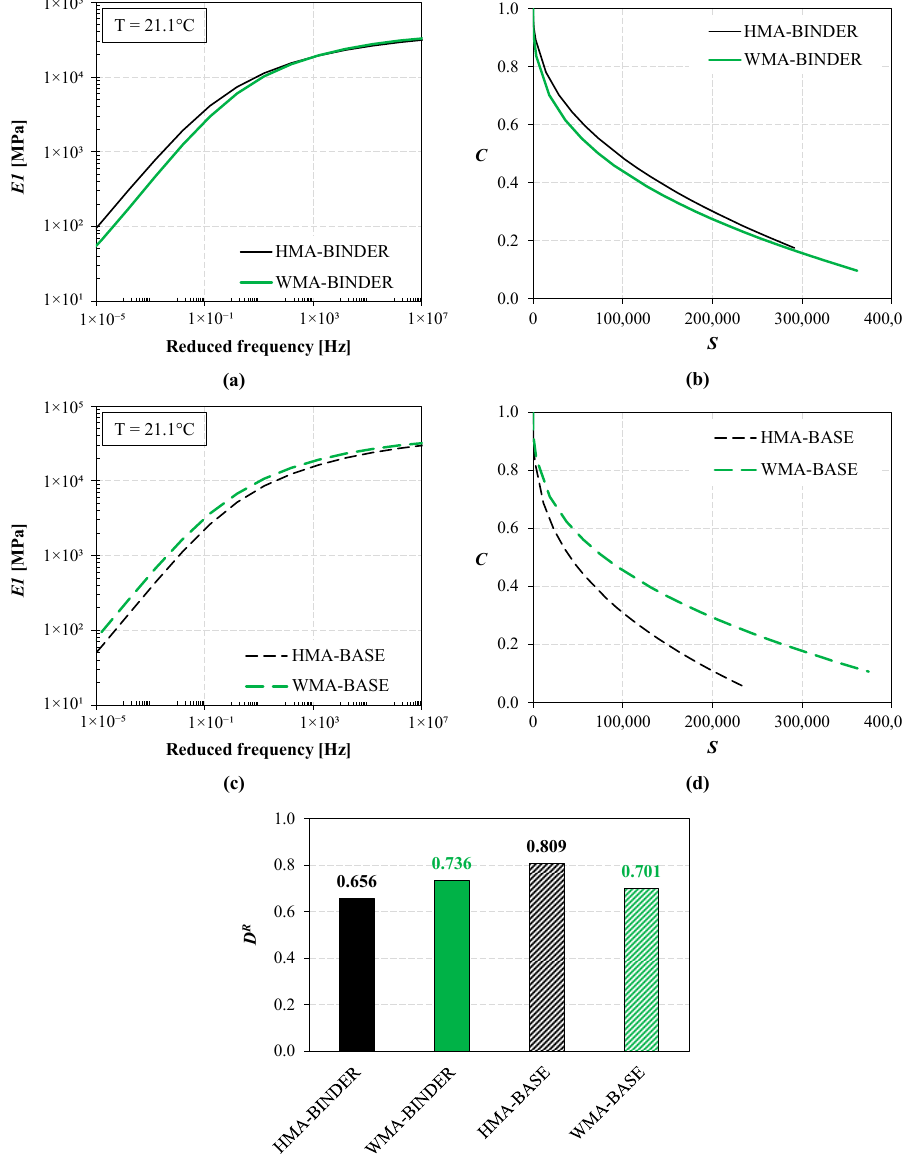
Figure 4. Properties of the materials from the field trial: ( a ) storage modulus master curve (2S2P1D model) and ( b ) damage characteristic curve of the binder course mixture, ( c ) storage modulus master curve (2S2P1D model) and ( d ) damage characteristic curve of the base course mixture, ( e ) D R values.